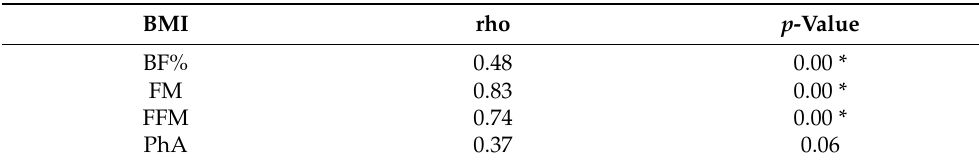
Table 5. Spearman correlation between BMI and particular parameters assessing body mass composi- tion.